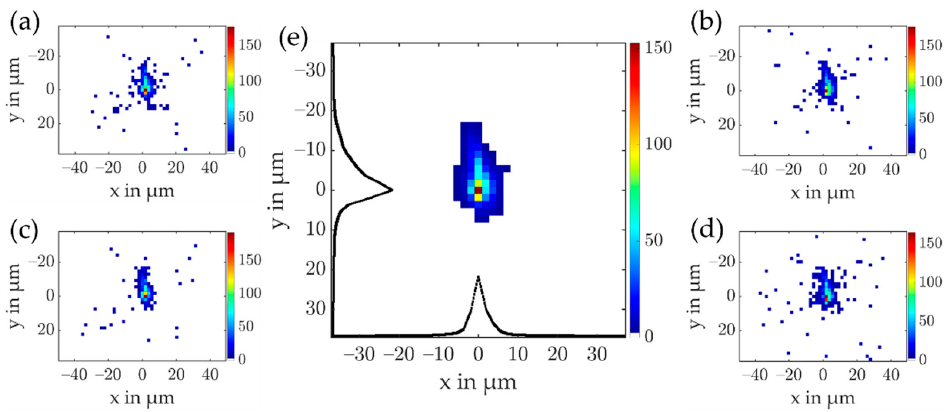
Figure 3. Focus of the XUV beam in the Zr window with closed iris ( ≈ 0.8 mm). The resolution of the camera is only limited by its pixel size. ( a – d ) Four single-shot images. ( e ) Average of 300 single-shot images. The black lines indicate the horizontal and vertical projections of the 2D focal image with FWHM spot sizes of 1.9 × 5.6 µm. The equivalent circle FWHM diameter is 3.6 µm.